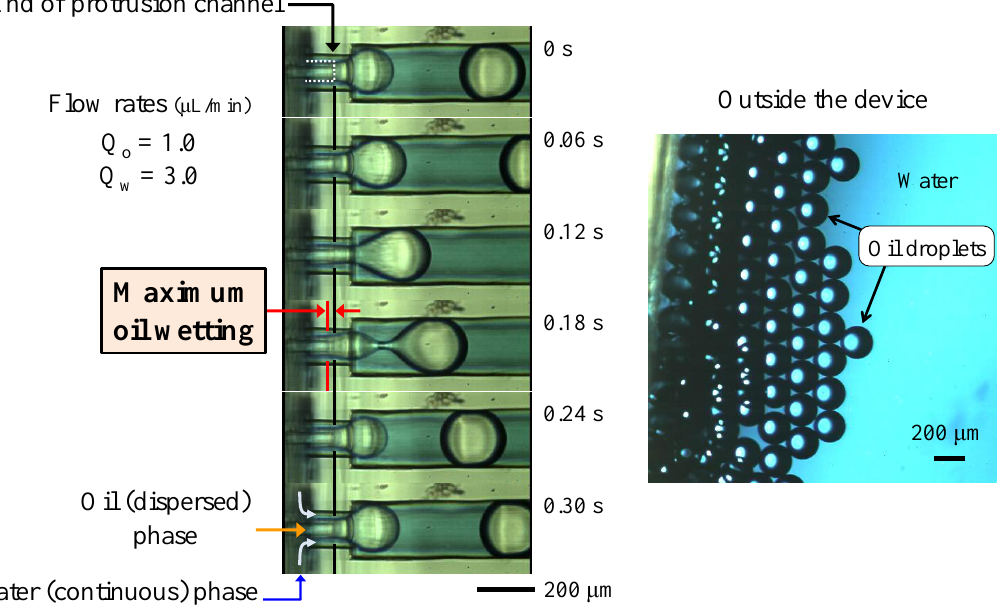
Figure 4. Visualization of the oil droplet (Oil-in-Water (O/W)) formation at the protrusion junction and the outside